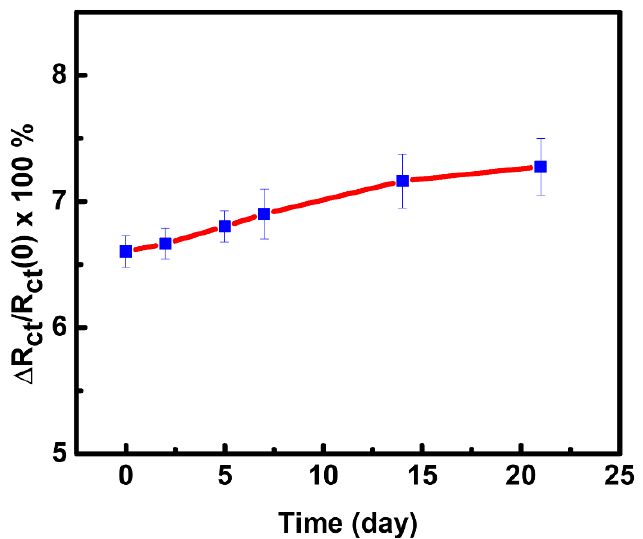
Figure 8. Long-term (21 days) durability test of ZIF-8 NPs/PEDOT:PSS/ITO based creatinine sensor in 1 mM creatinine solution obtained from EIS measurement.